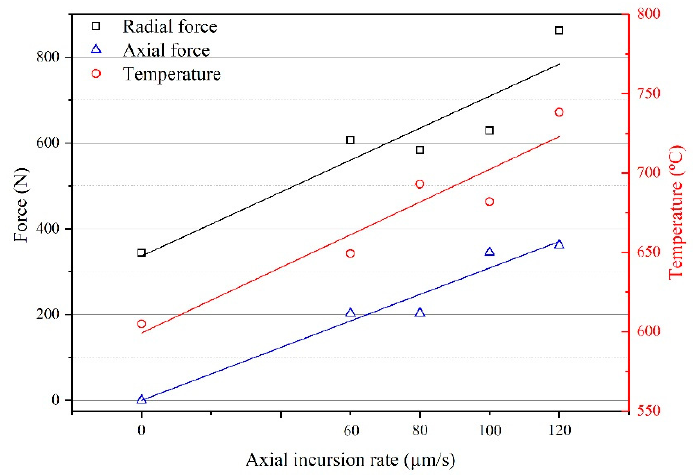
Figure 7. The maximum rubbing forces and temperature at different axial incursion rates.